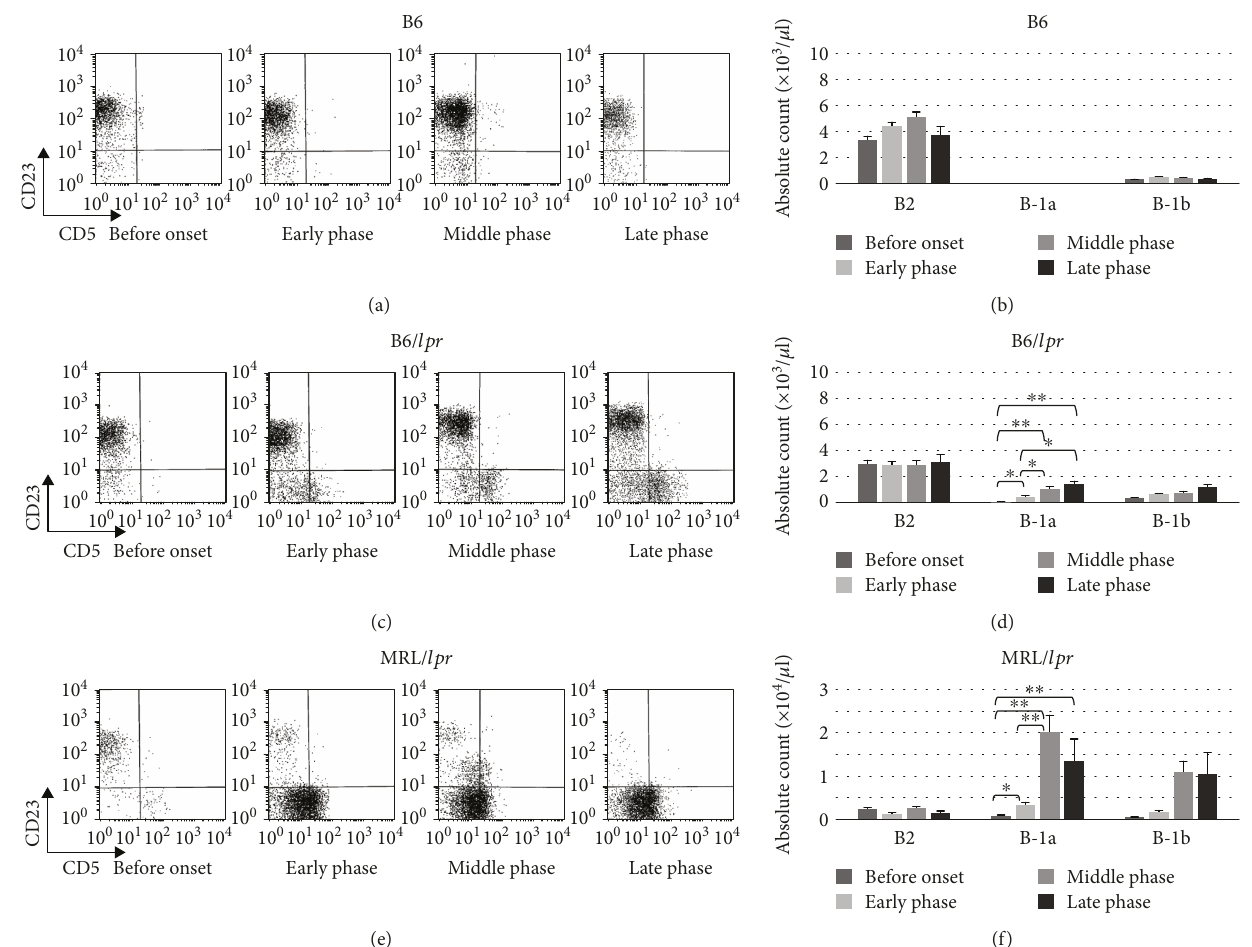
Figure 2: Cell-surface markers of B cells. Peripheral blood cells obtained from the B6 mice ( n = 32 ) were stained and analyzed with fl ow cytometry. Representative fl ow cytometry plots (a) and absolute count of B-1a, B-1b, and B-2 cells (b) are shown. Peripheral blood cells obtained from the B6/ lpr mice ( n = 35 ) were stained and analyzed with fl ow cytometry. Representative fl ow cytometry plots (c) and absolute count of B-1a, B-1b, and B-2 cells (d) are shown. Peripheral blood cells obtained from the MRL/ lpr mice ( n = 27 ) were stained and analyzed with fl ow cytometry. Representative fl ow cytometry plots (e) and absolute count of B-1a, B-1b, and B-2 cells (f) are